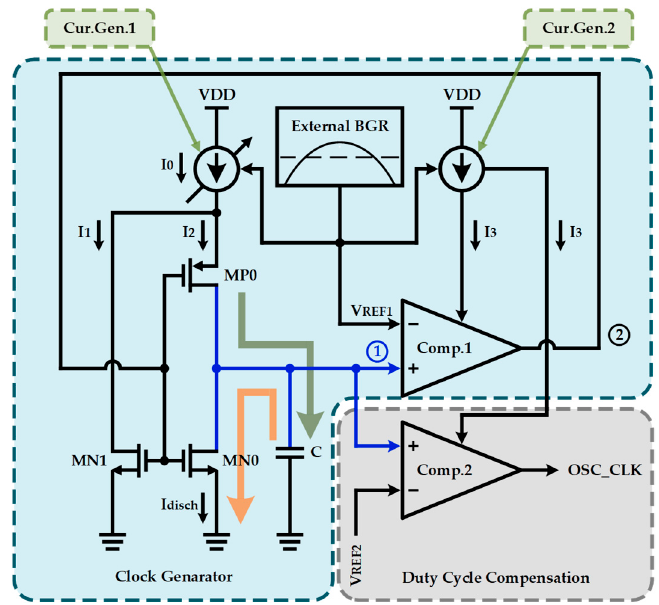
Figure 1. Architecture of the proposed relaxation oscillator.